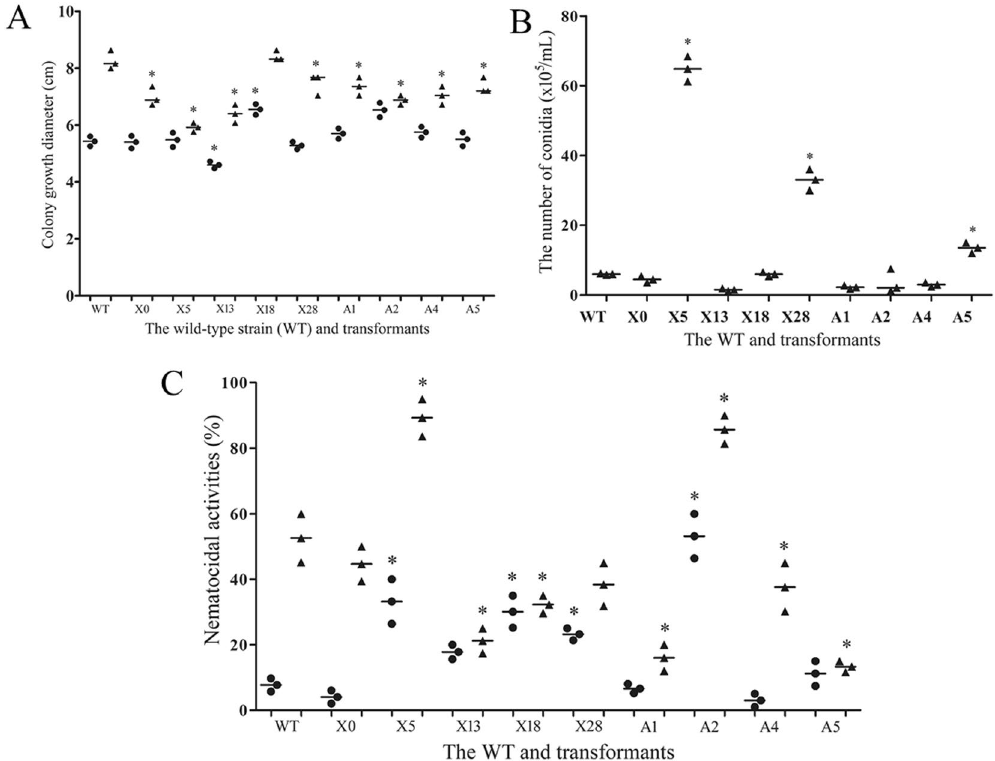
Figure 1. Phenotypic properties of the WT and nine transformants. ( A ) The growth rates of WT and transformants on TYGA (dots) and PDA (triangles) plates. * P < 0.05 versus WT. ( B ) Conidiation of WT and transformants on CMA plate at 26 °C for 2 weeks. * P < 0.05 versus WT. C. Comparison on the nematocidal activities of WT and transformants on WA (water agar) plate. * P < 0.05 versus WT at 10 h (dots) and 24 h (triangles), respectively. The horizontal bars depict the median, and data are presented as suggested by Weissgerber et al . 58 and Klaus 59